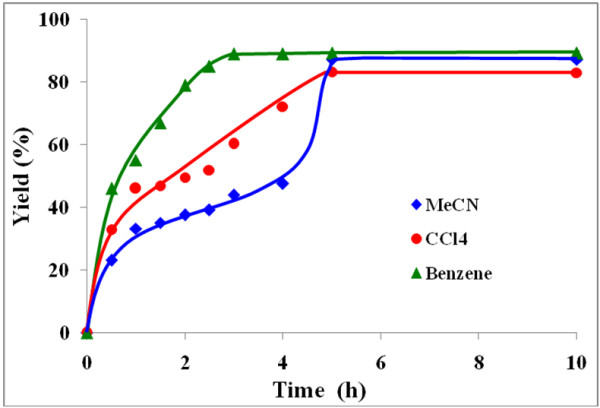
Effect of solvent on % yield of benzil using VOL2 at 50°C.